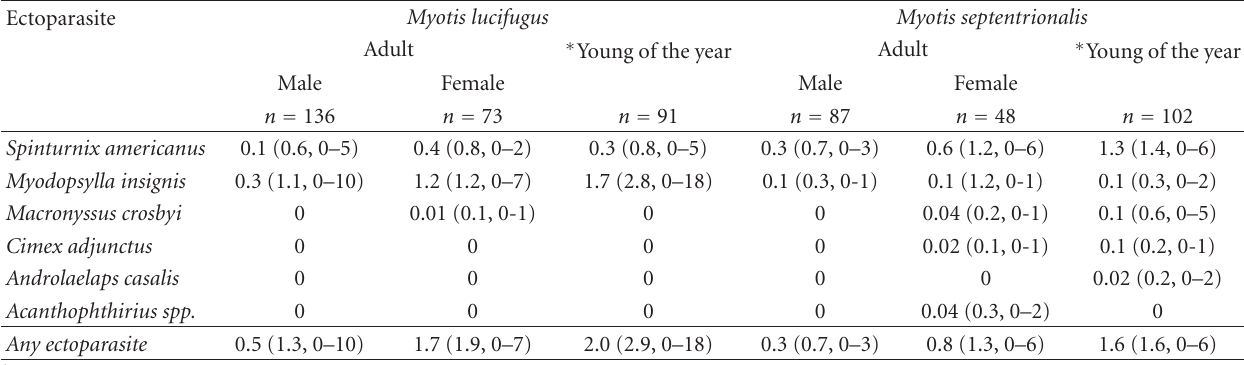
Table 3: Mean intensity (standard deviation and range) of ectoparasites among the di ff erent host groups at all sample sites in Nova Scotia and New Brunswick during swarming, Aug–Oct